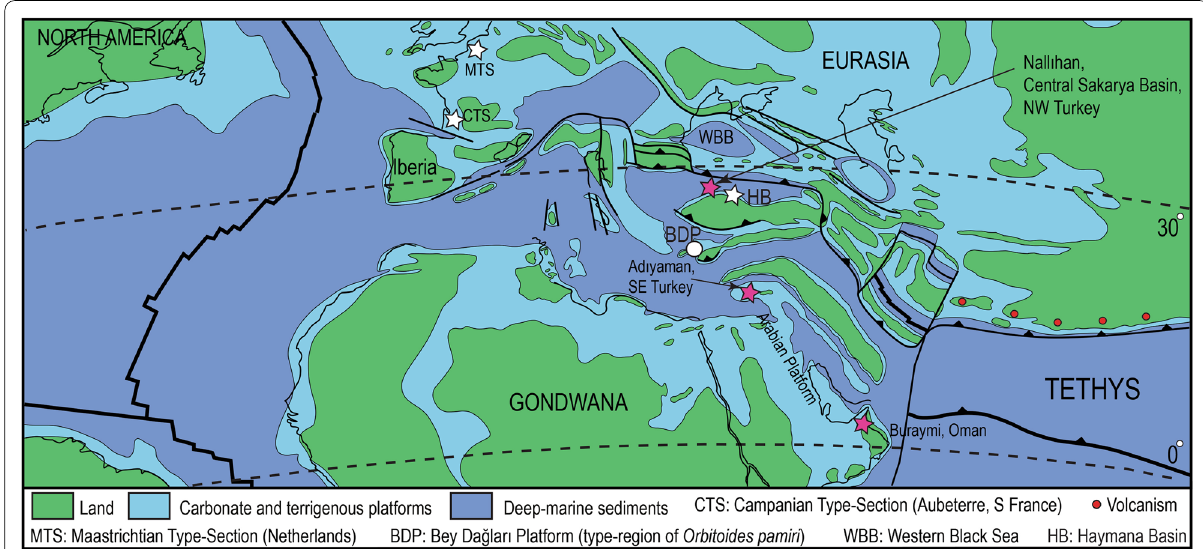
Fig. 2 Maastrichtian palaeogeography and locations of the studied sections in Turkey and Oman (shown by red) (map simplified from Barrier et al. 2018). The locations of the Campanian and Maastrichtian type sections in SW France and the Netherlands and the Haymana Basin in Central Turkey are